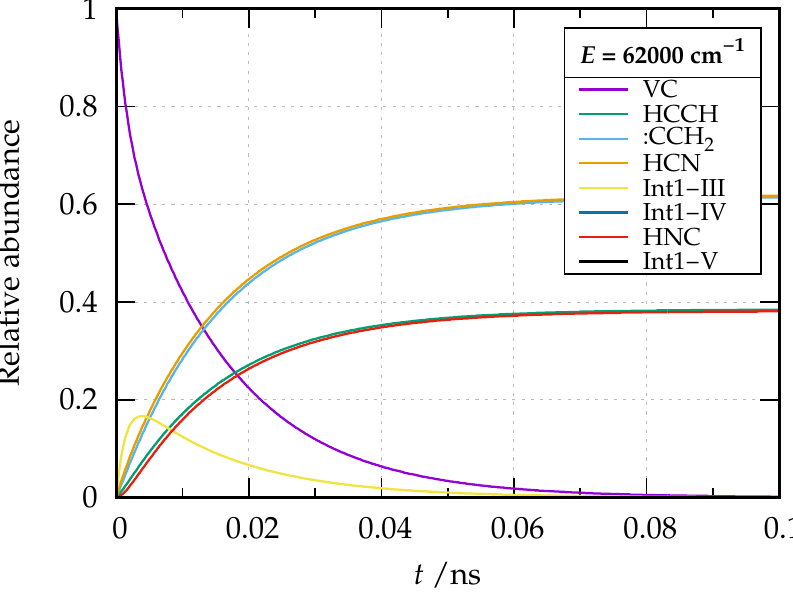
Figure 9. Relative abundance of the species involved in the dissociation of vinyl cyanide as a function of time at energy E = 62000 cm − 1 relative to the reactant zero-point